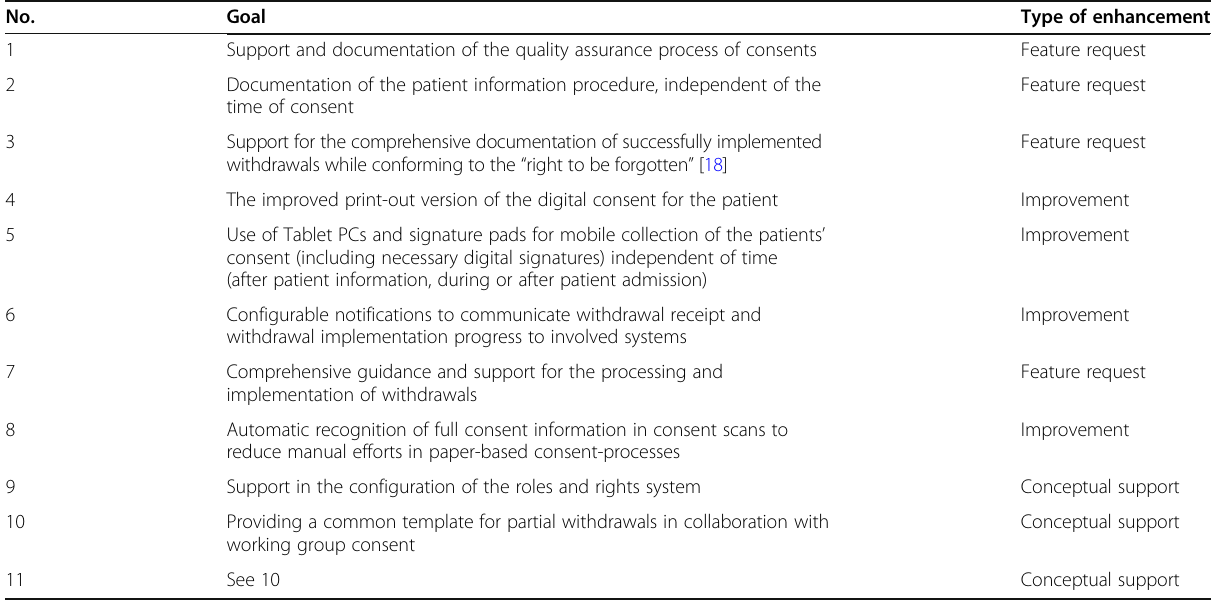
Table 6 Resulting feature requests, improvements and conceptual supports. Features that were already available in the gICS